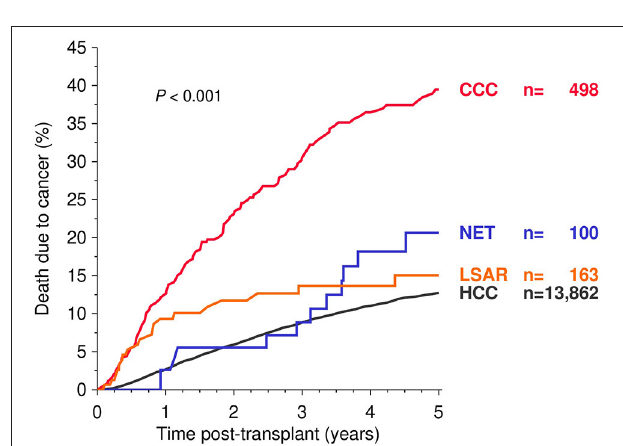
FIGURE 2 | Kaplan-Meier analysis of death due to cancer during the first five post-transplant years. Global log-rank P -values are shown. HCC, hepatocellular carcinoma; CCC, cholangiocellular carcinoma; NET, neuroendocrine tumor; LSAR, sarcomas of the